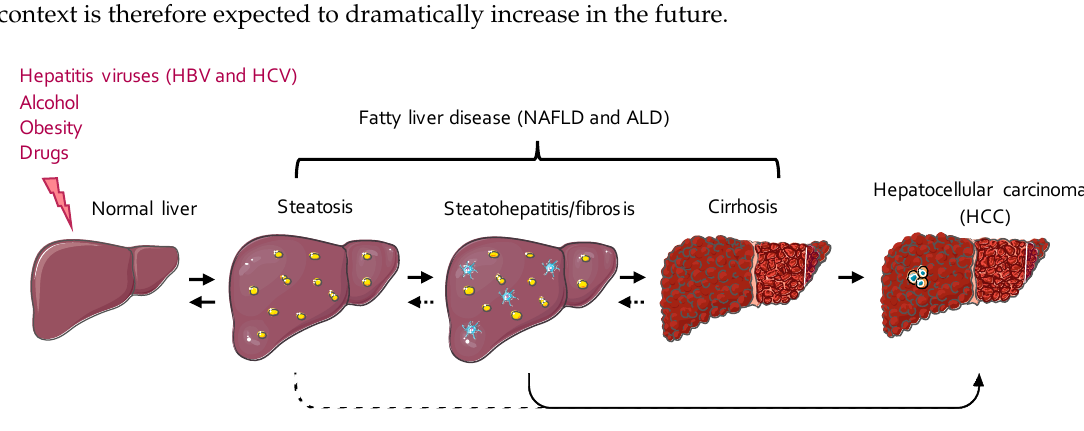
Figure 1. The spectrum of the di ff erent stages of fatty liver disease (FLD) and its progression toward hepatocellular carcinoma (HCC). The first stage of FLD usually consists of an aberrant accumulation of fat in the hepatocytes, under the form of cytoplasmic lipid droplets, a pathological situation called steatosis. Hepatic steatosis can then progress to steatohepatitis, a chronic inflammatory state often accompanied by the development of fibrotic scars replacing the parenchymal hepatic tissue. Extended fibrosis and the development of undi ff erentiated regenerating hepatocyte nodules further characterize the progression of steatohepatitis and fibrosis to cirrhosis. Cirrhosis represents an important risk factor for the progression of FLD toward the development of hepatocellular carcinoma (HCC), which may also occur in noncirrhotic livers displaying only inflammation / fibrosis. ALD, alcoholic liver disease; HBV, hepatitis B virus; HCV, hepatitis C virus; NAFLD, nonalcoholic fatty liver disease.